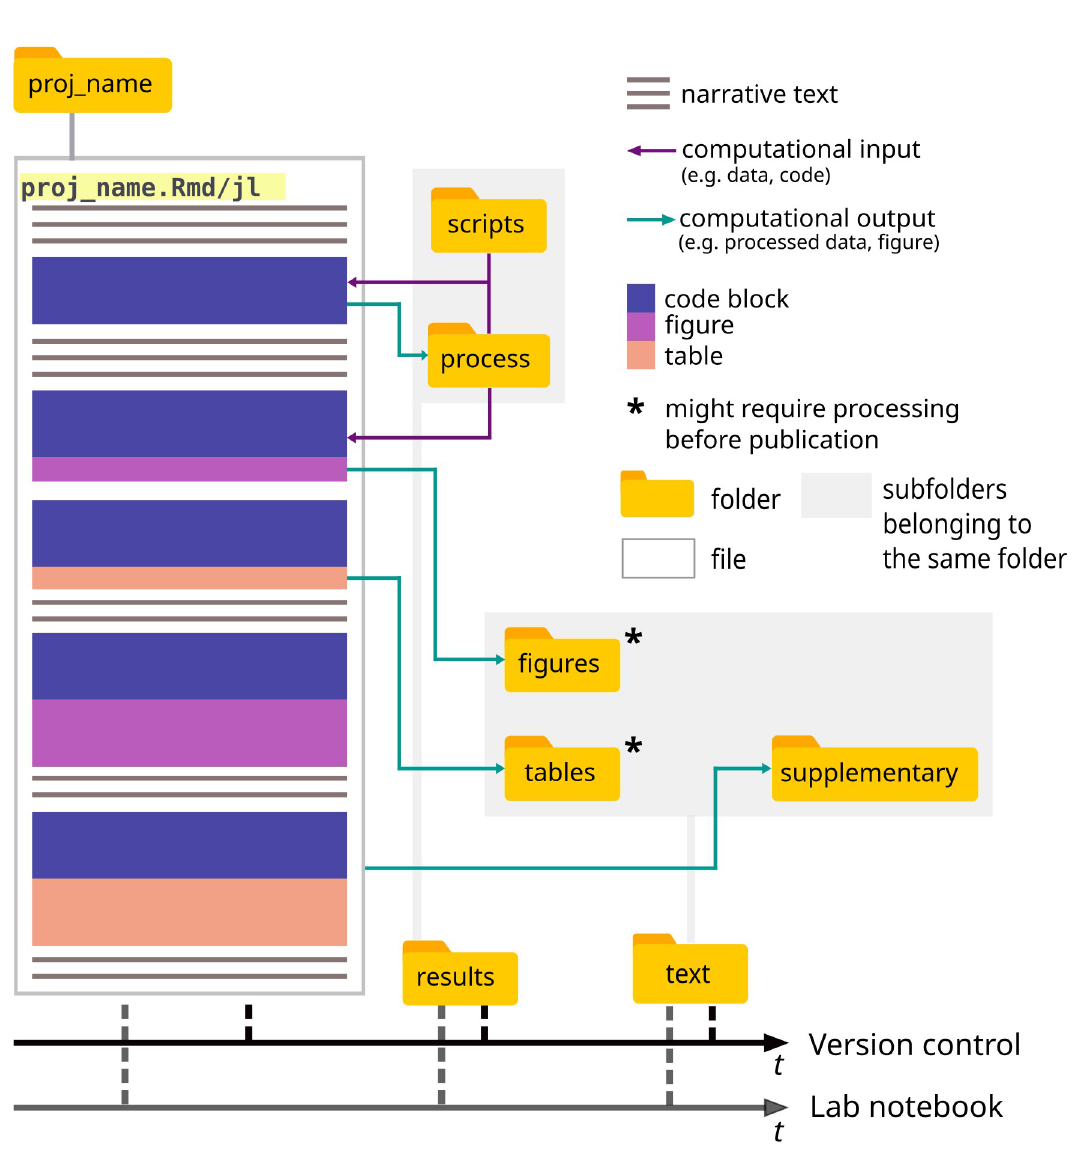
Fig 2. Schematics of the organization of a research project (proj_name) around a computational notebook (proj_name.Rmd/jl, referring to an RMarkdown or Julia file). The notebook contains narrative text supplementary to the manuscript’s main text, as well as text explaining the reasoning behind the computational work (included as code blocks) and its respective outputs (either kept on the notebook or saved as figures or tables). The notebook stays at upper level of a file structure (Fig 1), which provides easy access to all relevant folders for input (purple) and output (green) files through relative paths. The gray area shows subfolders that are nested inside folders (e.g., the figures and tables folders are inside the text folder). The notebook, along with all the files in the project’s folder, can be subjected to version control and be referenced in a lab notebook, thanks to the nested structure of the project. We recommend publishing it as your main supplementary material to the manuscript, along with a rendered version (.pdf or.html), any scripts, and not yet public data you